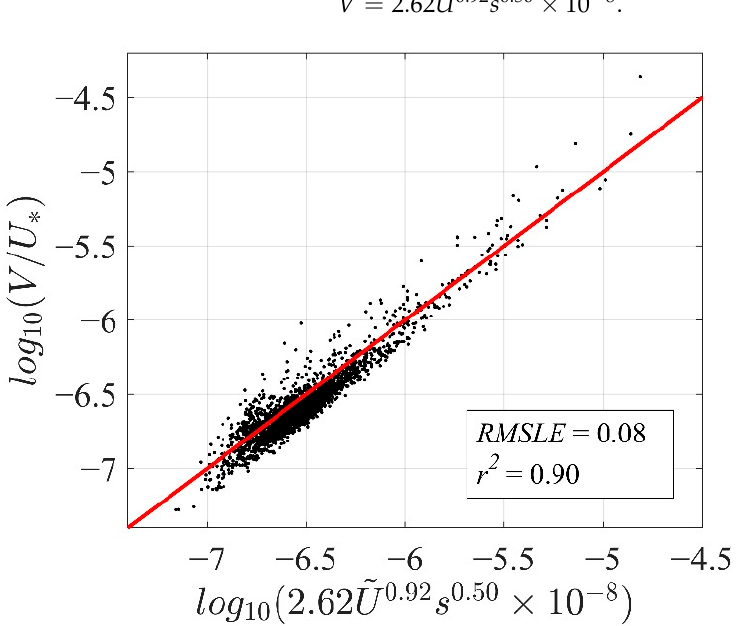
Figure 9. Logarithm-scale plot of dimensionless sea spray volume flux of the measurement versus wind–wave-dependent model (Equation (7)). The solid red line is 1:1 line. Taking into consideration that Equation (7) is an empirical fit rather than a complete physical construct, we hypothesize that the volume flux varies linearly with the non- dimensional wind speed and as the square of the mean wave steepness. In that case, Equation (7) reduces to the